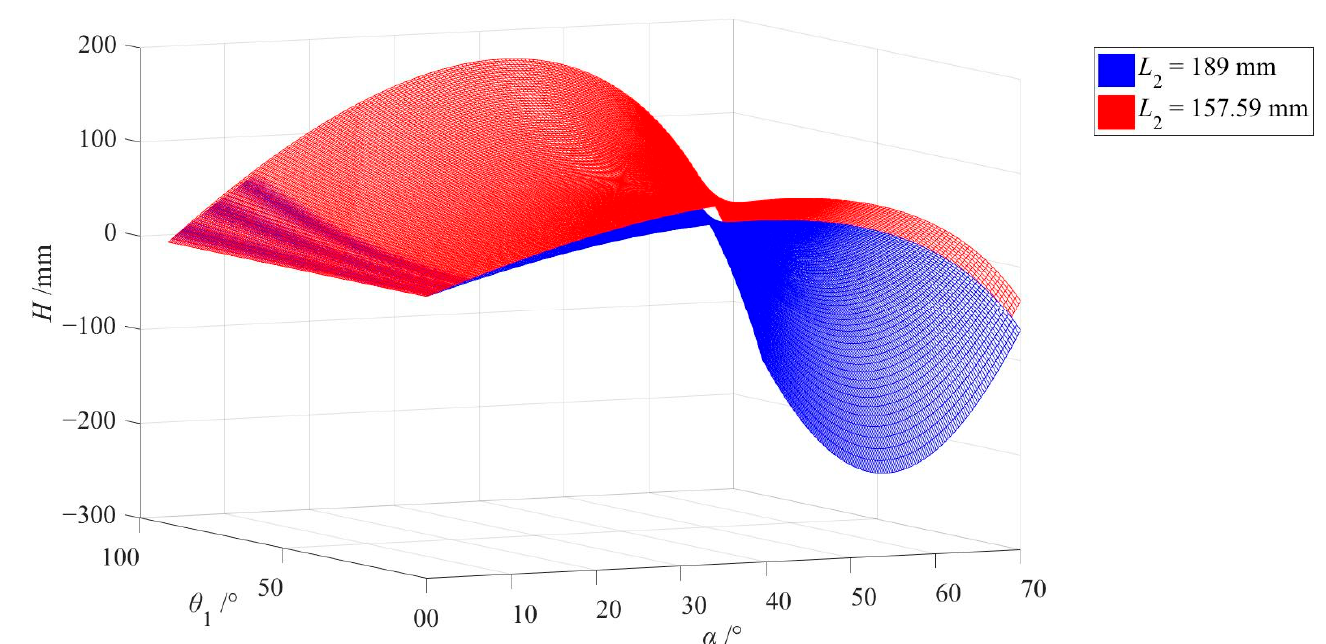
Figure 15. Comparison of obstacle heights with different arm lengths.